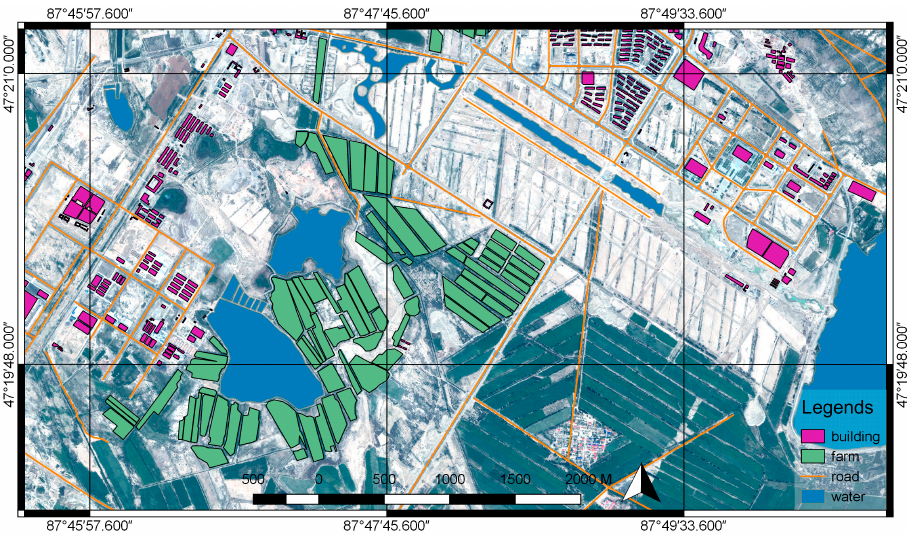
Figure 7. The merged 0.5 m RGB image and the vectorization result. Table 1. The error parameters of the IMU determined by the Allan variance analysis.